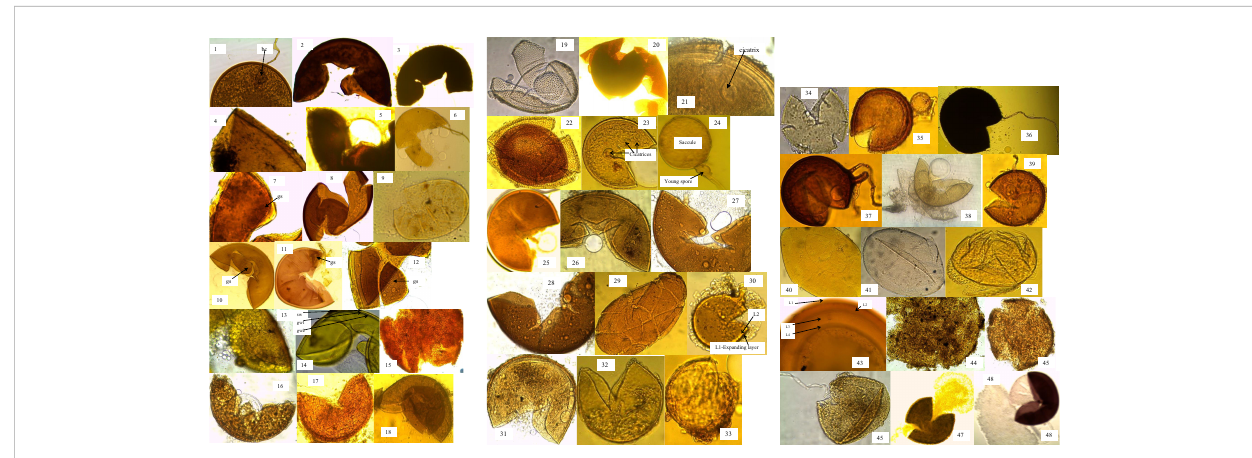
FIGURE 2 Some of the Glomeromycotan species identi fi ed from fi eld soils across the AEZs and CTs. Magni fi cation x40, bc, bulbous cell; gs, germination shield; sw, spore wall; gw, germination wall, l,layer, 1-6= Gigaspora spp., 7-12= Scutellospora spp., 13-20= Acaulospora spp., 21-25= Entrophospora spp., 26-39= Glomus spp., 40-48= Unde fi ned